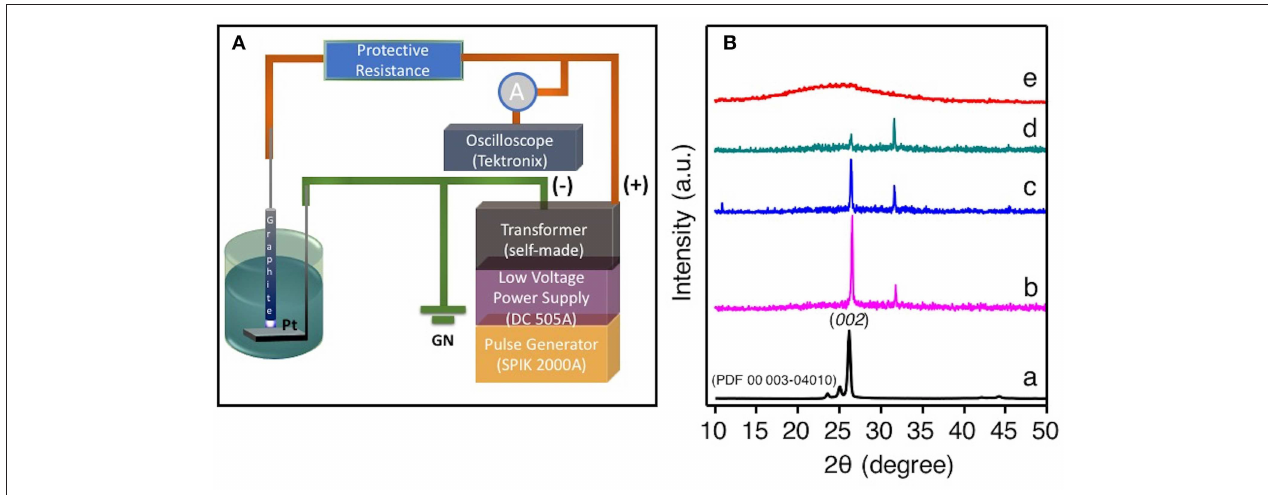
FIGURE 1 | (A) The systematic representation of graphite exfoliation in ACN by SLEP setup. (B) The powder XRD pattern of pristine graphite (a), Exfoliated graphite obtained by SLPE in the presence of various concentration ranging from 5mM (b), 2.5mM (c), 1mM (d), and (e) 0.1mM sodium tetraphenylborate-NaBPh 4 in 0.77 mol